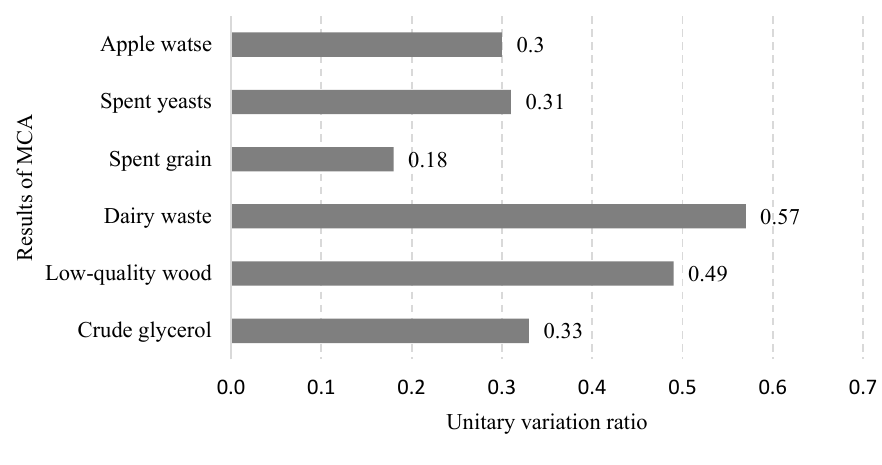
Fig. 3. Relative closeness to the ideal solution with TOPSIS